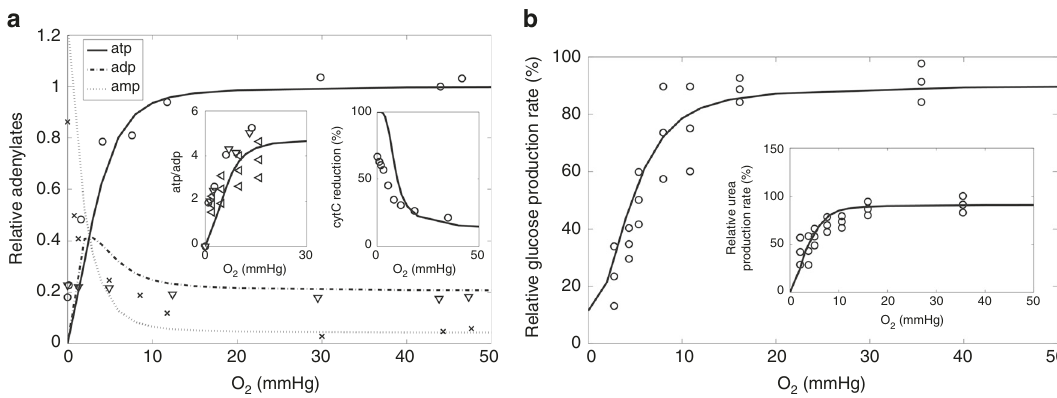
Fig. 2 Effect of hypoxia on selected model variables. a Adenine nucleotides ATP, ADP, and AMP. Small insertions: ATP/ADP ratio and reductions state of cytochrome c. b Relative production rates of glucose and urea (small insertion). Discrete symbols refer to experimental data from various publications. For details see Supplementary Note